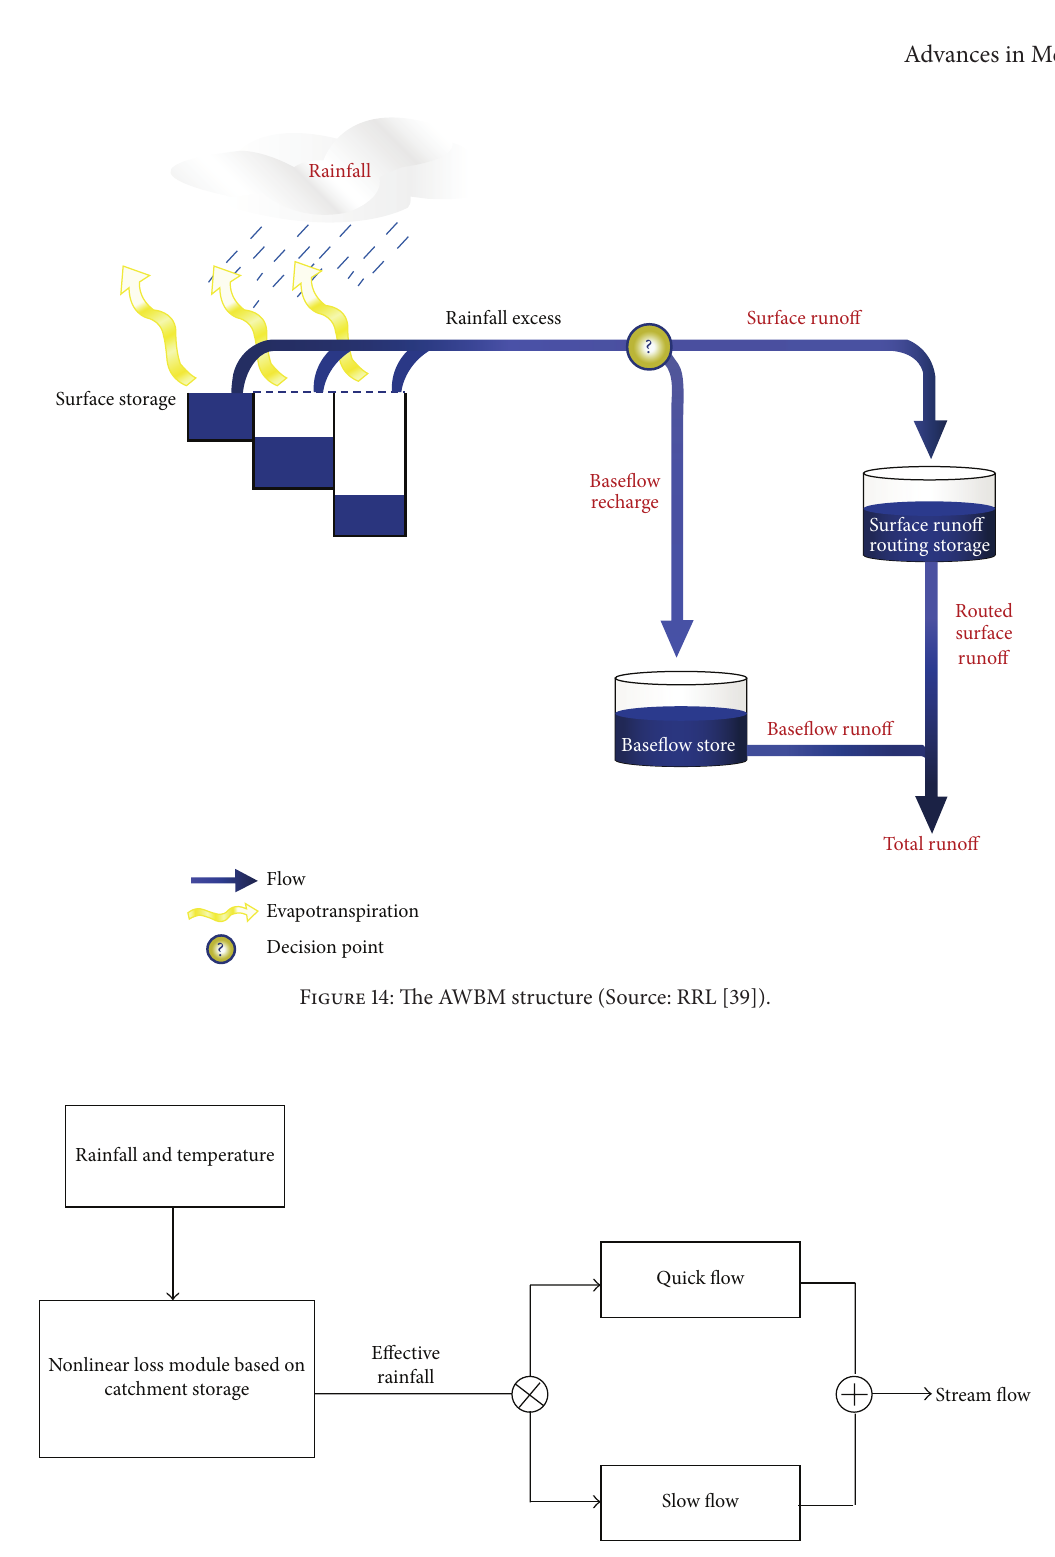
Figure 15: The IHACRES model